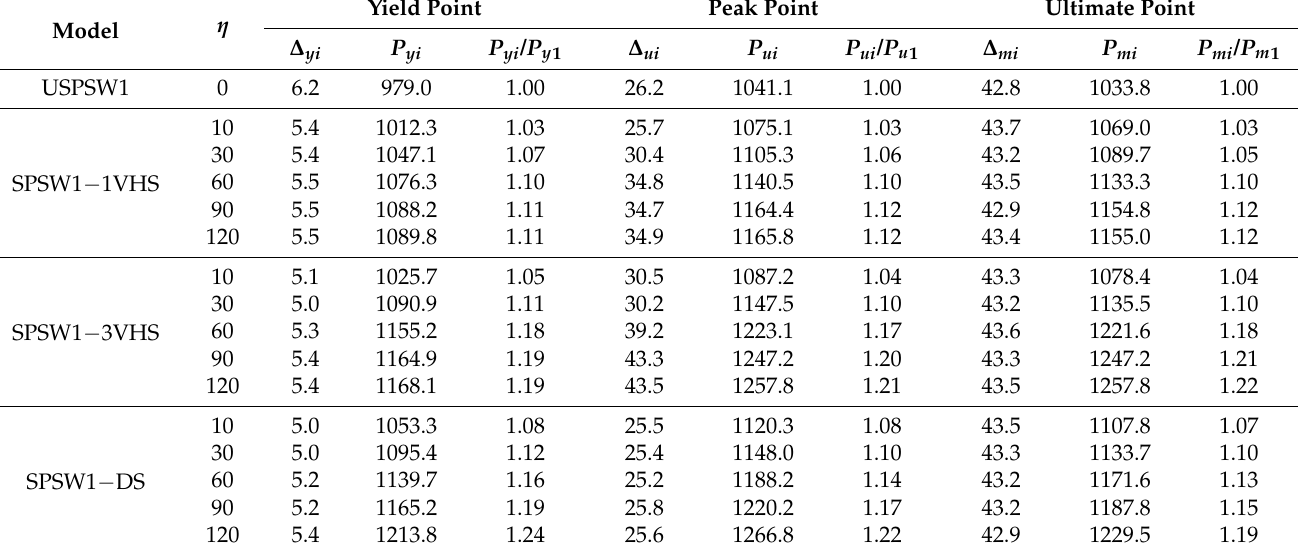
Table 3. Analysis results of SSPSWs with variable η